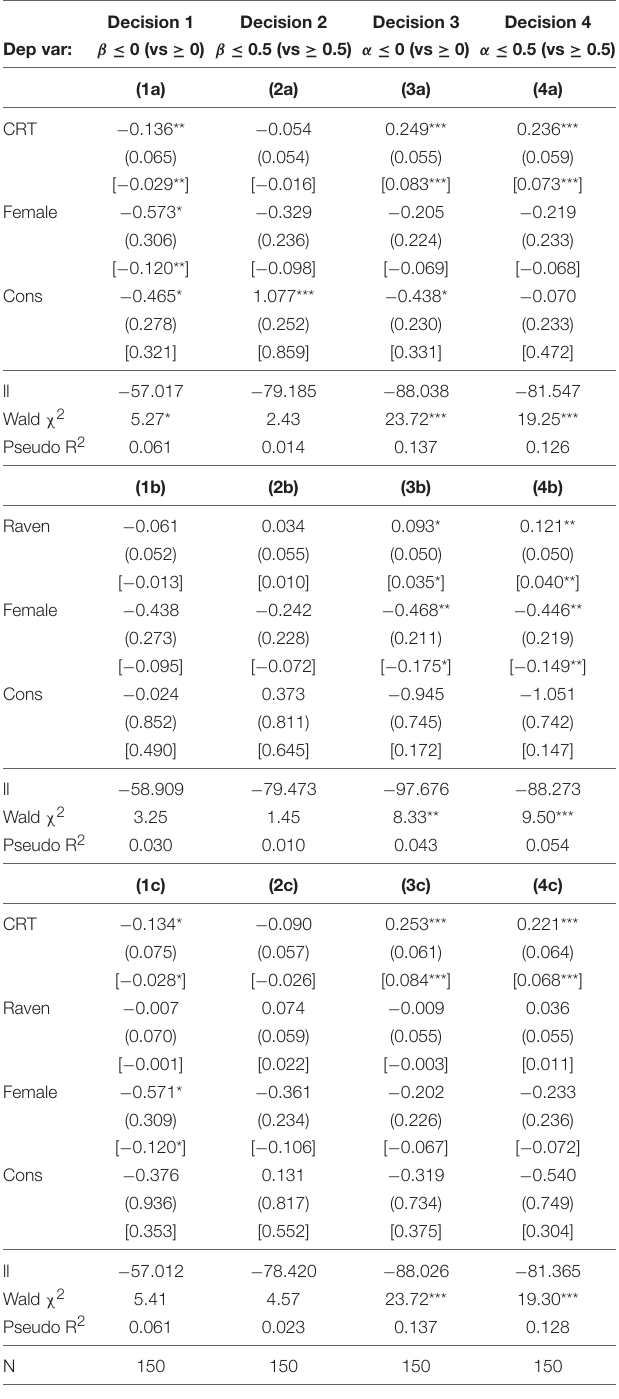
Probit estimates. The α and β parameters associated with the dependent variable are displayed on top of each column. In “a” regressions, the main explanatory variable is CRT score.In“b”regressions,themainexplanatoryvariableisRavenscore.In“c”regressions, both CRT and Raven scores are included as explanatory variables. Robust standard errors clustered on individuals are shown in parentheses and average marginal effects of the explanatory variables are shown in square brackets (for the constant, this value represents the probability obtained from normal transformation of the Probit coefficient). * , * , *** denote p-values lower than 0.10, 0.05, and 0.01, respectively.